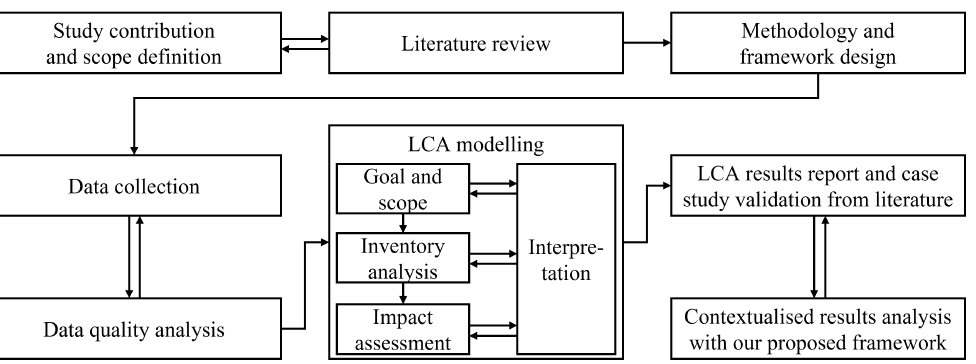
Figure 1. Methodology flowchart. Our proposed framework extends existing industry standards to en- sure that it may be seamlessly adopted by industry practitioners. Therefore, ISO regulations 14040 [12] and NHS emission reporting standards [13,14] have significantly influenced our methodology, LCA models, and result